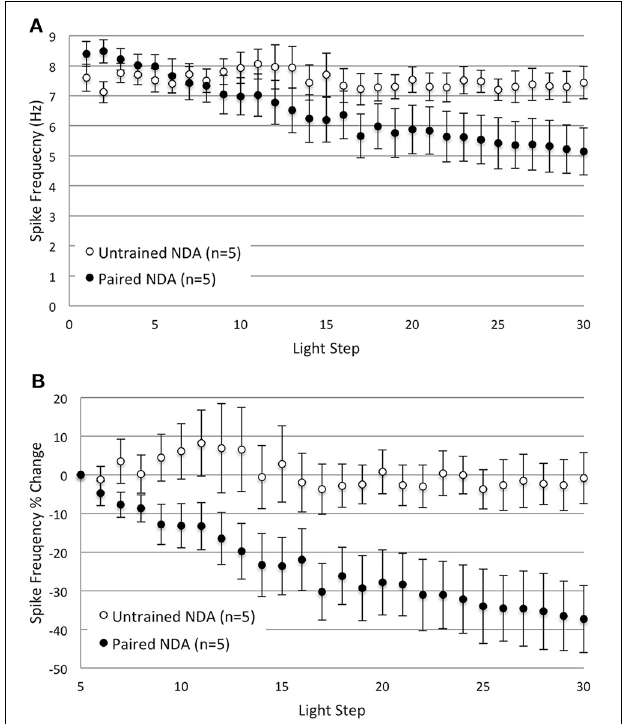
FIGURE 3 | Omitting the 10min re-dark adaptation period between LSs 15 and 16 did not substantially alter the decreases in B cell spike frequency produced by repetitive LSs in Paired cells. (A) Summary spike frequency data of Type B cells with no re-dark adaption period ( NDA groups) in response to 30 successive LSs. Paired NDA cells showed a large decrease in spike frequency, while Untrained NDA cells showed very little change over the course of 30 LSs. These results were not appreciably different from the spike frequencies observed in their re-dark adapted counter parts (see Figure 2 ). Untrained NDA cells showed little reduction in light-evoked spike frequency over LSs 16–30, while Paired NDA cells exhibited a decline that grew significantly larger over time (significant interaction between LS and condition). (B) Summary data of the relative percent change in B cell spike frequency from the 5th to 30th LS. Paired NDA cells exhibited a significant decline in spike frequencies ( ∼ 37%) compared to the negligible decrease observed in Untrained NDA cells ( ∼ 1%). Error bars are ± s.e.m. and significant p -values are < 0.05. Note that one Paired NDA cell was excluded from analysis during LSs 5–30 and LSs 16–30 because impalement was lost after LS